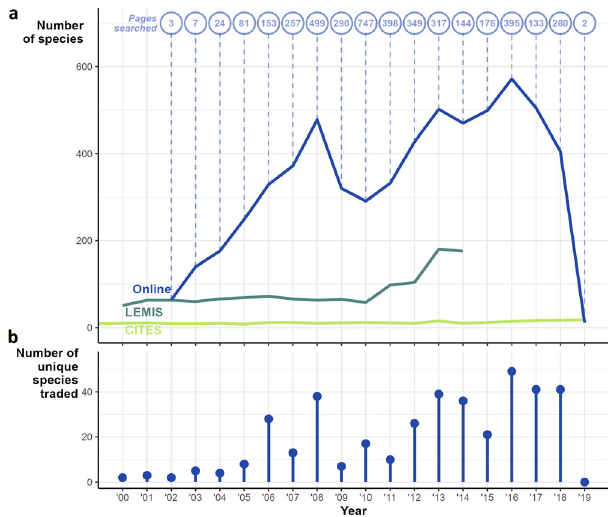
Fig. 3 Numbers of species listed per year from the three data sources. a The raw number of species in each of the data sources, supplemented with a count of the archived pages searched to describe the varying online sampling effort. b The number of species unique to that particular year, from any source.